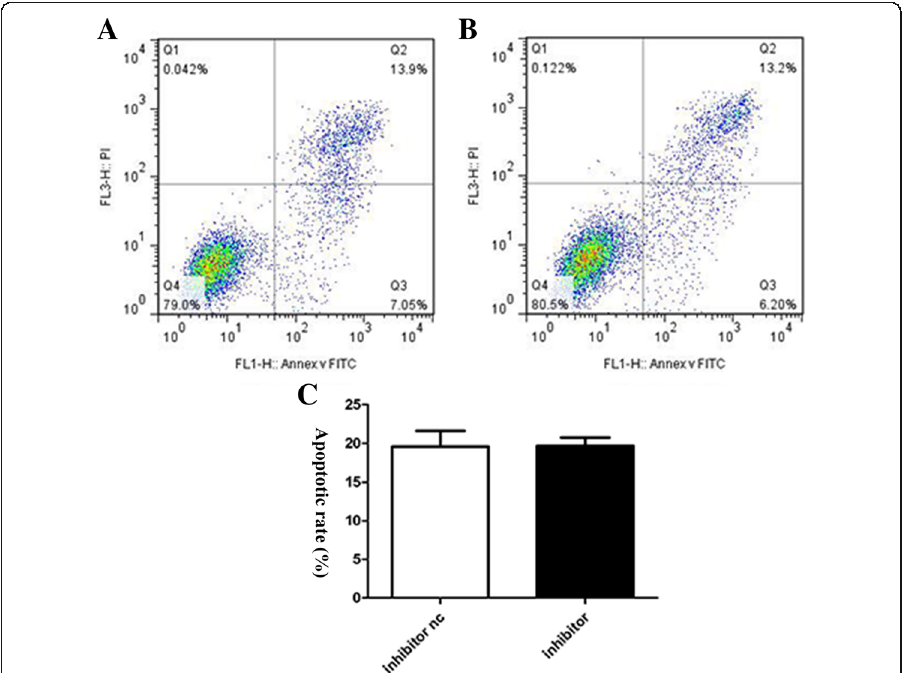
Fig. 4 Apoptosis was assayed based on the binding of propidium iodide/AV-FITC. a – miR-431-5p inhibitor NC group. b – miR-431-5p inhibitor group. c – Flow cytometry was used to assess the apoptotic rate ( n = 3) ** p < 0.01 vs. miR-431-5p negative